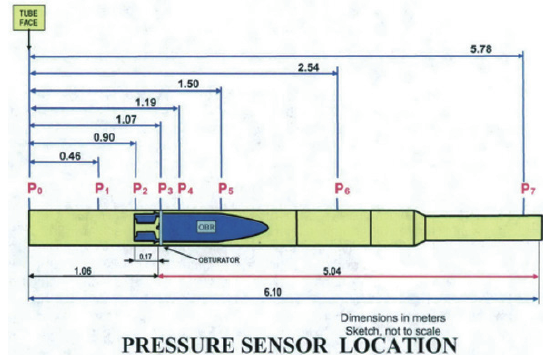
Fig. 2. On board recorder and gun pressure gage